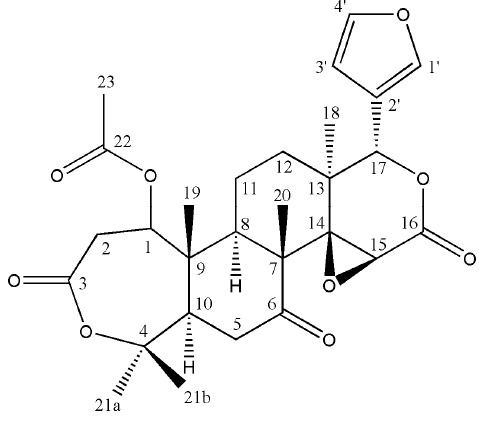
Figure 2. Structure of nomilin {7-(furan-3-yl)-1,8,12,17,17-pentamethyl-5,15,20-trioxo-3,6,16-tri- oxapentacyclo [9.9.0.0², ⁴ .0², ⁸ .0¹²,¹ ⁸ ]icosan-13-yl acetate} derived from yuzu seed